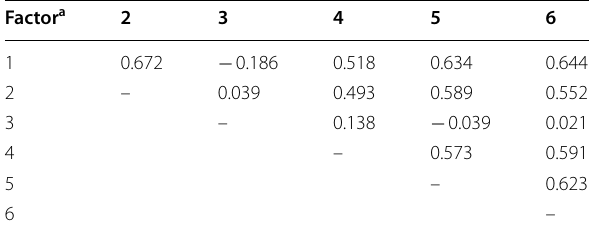
Table 2 Correlation matrix for the 6 factors in the EFA with direct Oblimin rotation for the DERS